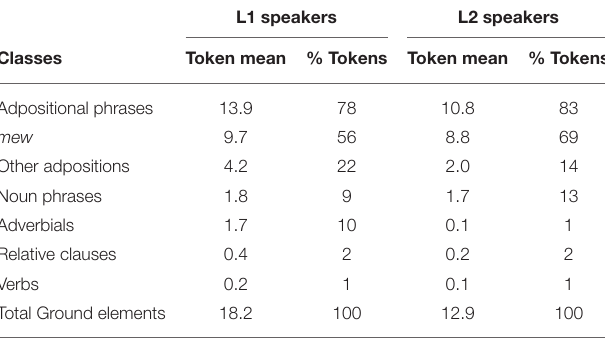
TABLE 4 | Different devices used to encode Ground in L1 and L2